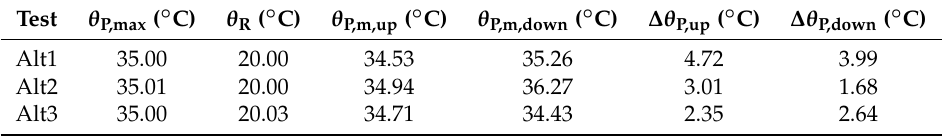
Table 7. Experimental result of surface temperature (additional